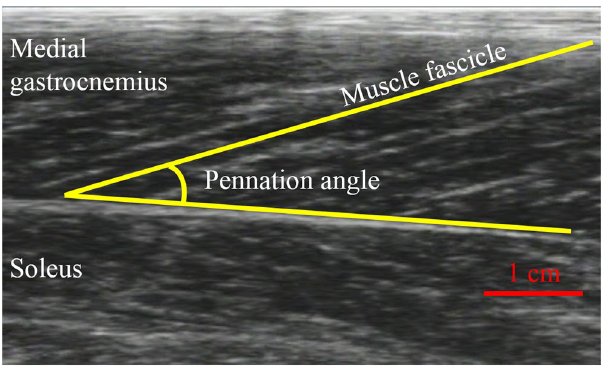
Figure 4. Illustration of how muscle fascicle length and pennation angle are